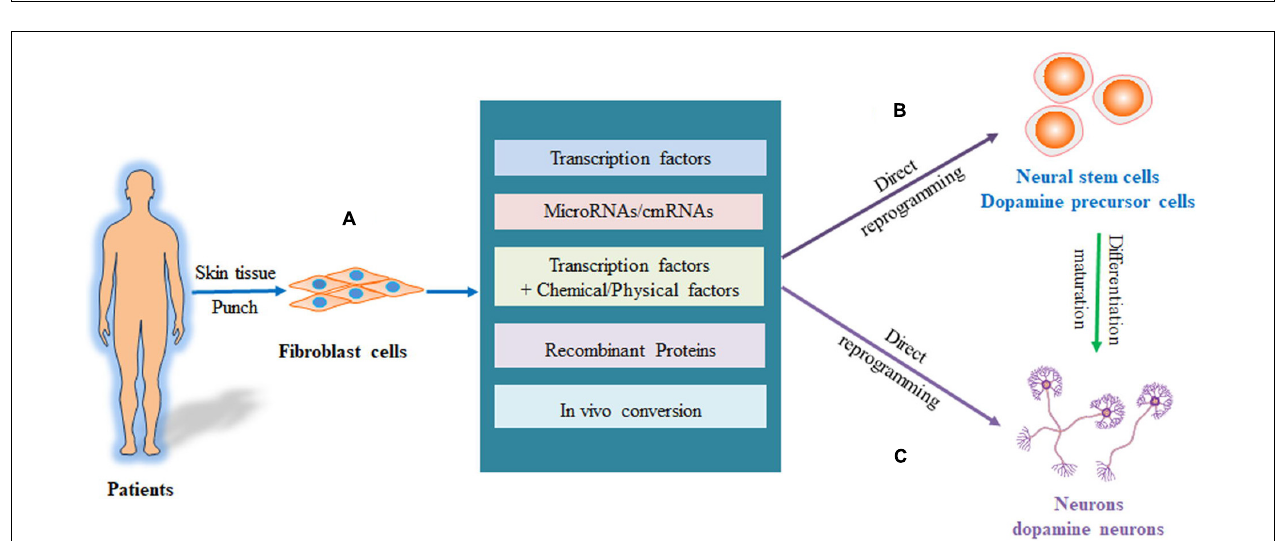
FIGURE 1 | Transcriptional regulation of embryonic stem cells into mesencephalic dopamine progenitor and mature dopamine neurons. The development of dopamine neurons has four stages: regional neural specification, middle brain dopaminergic precursor cells, immature dopamine neurons, and immature dopamine neurons. These are controlled by different transcription factors.